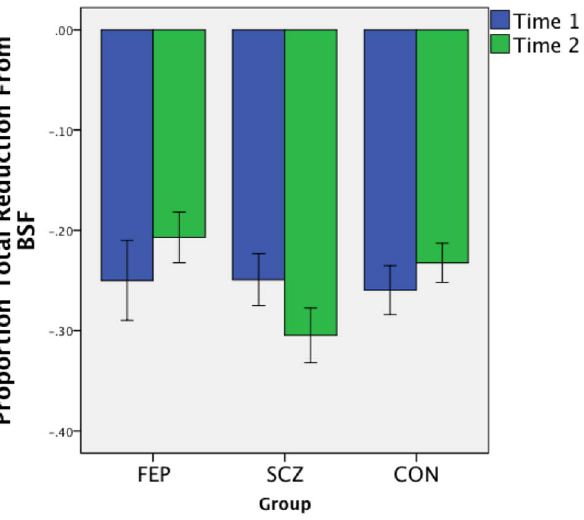
Fig. 4. Overall degradation in performance from BSF (summed across HSF and LSF conditions), by group and time. Error bars reflect + / 2 1